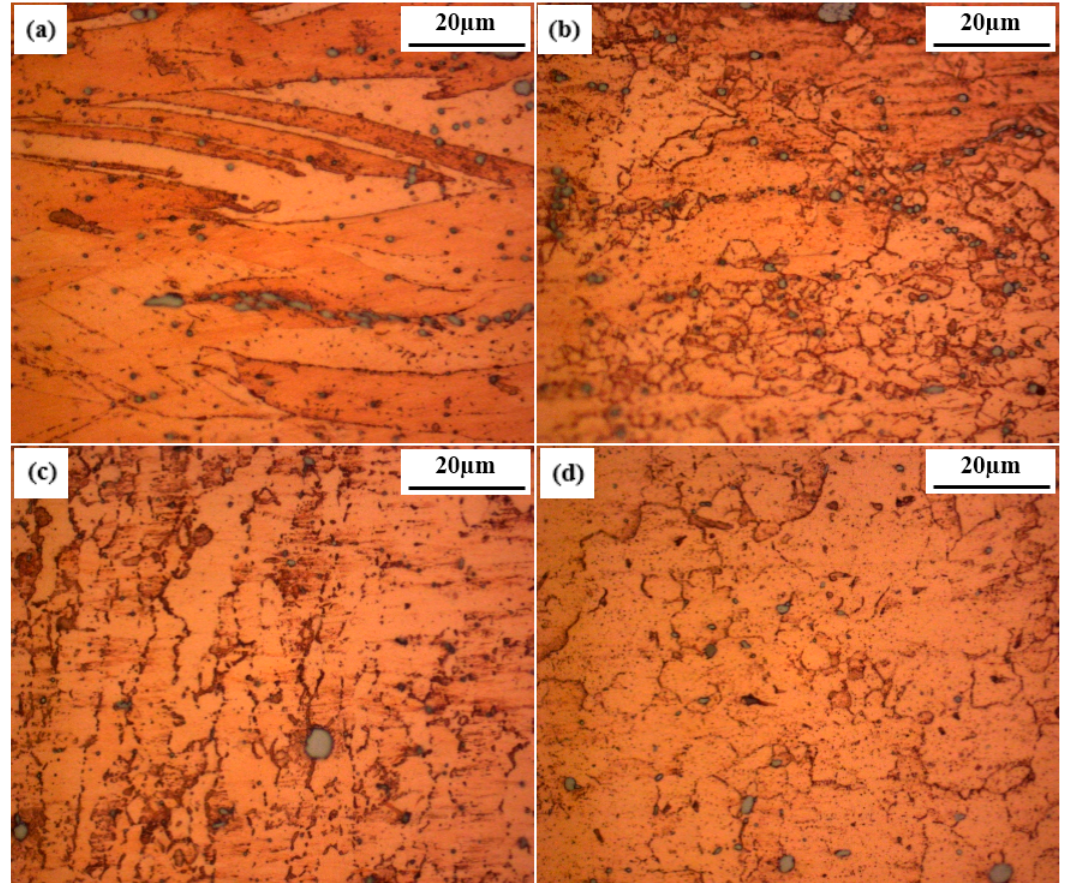
Figure 4. Microstructures of friction stir-welded CuCrZr alloy joints. ( a ) Base metal (BM), ( b ) heat affected zone (HAZ), ( c ) thermo-mechanically affected zone (TMAZ), and ( d ) nugget zone (NZ).